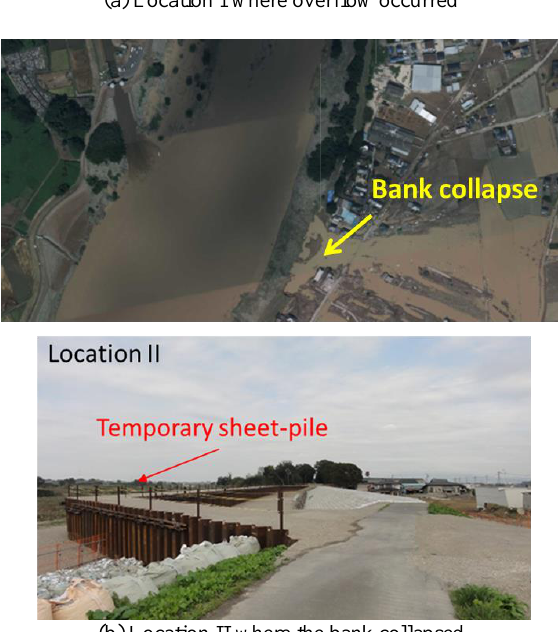
Figure 4. Aerial images taken by GSI on September 11, 2015 (up) and ground photos taken by the authors’ field survey on October 29, 2015 (down) for the two major damage sites.